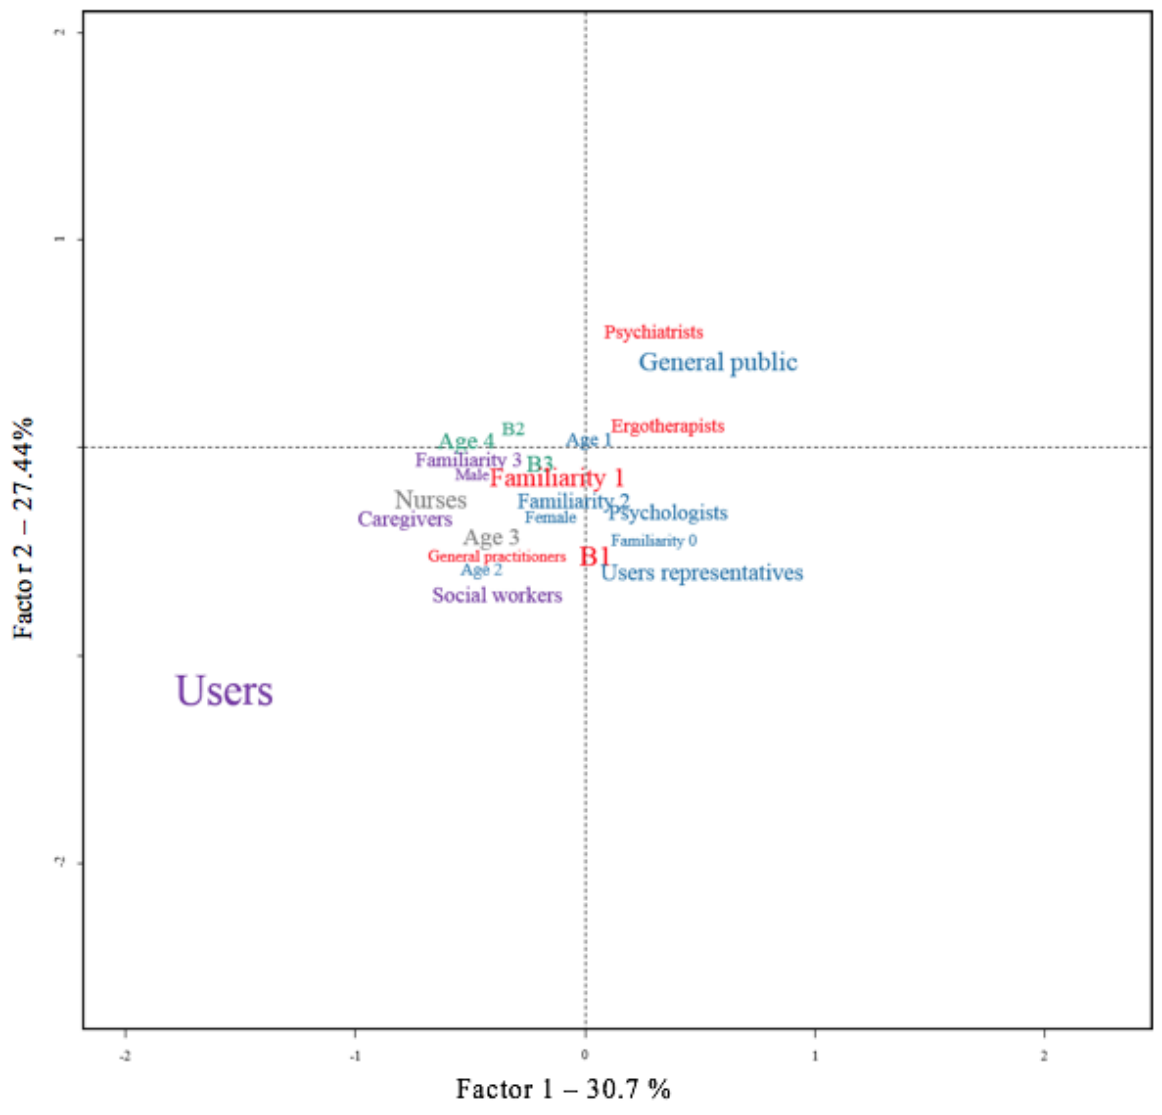
Figure 3. Correspondence factor analysis with the different variables studied. B1: text segment 1; B2: text segment 2, B3; text segment 3; Age 1: